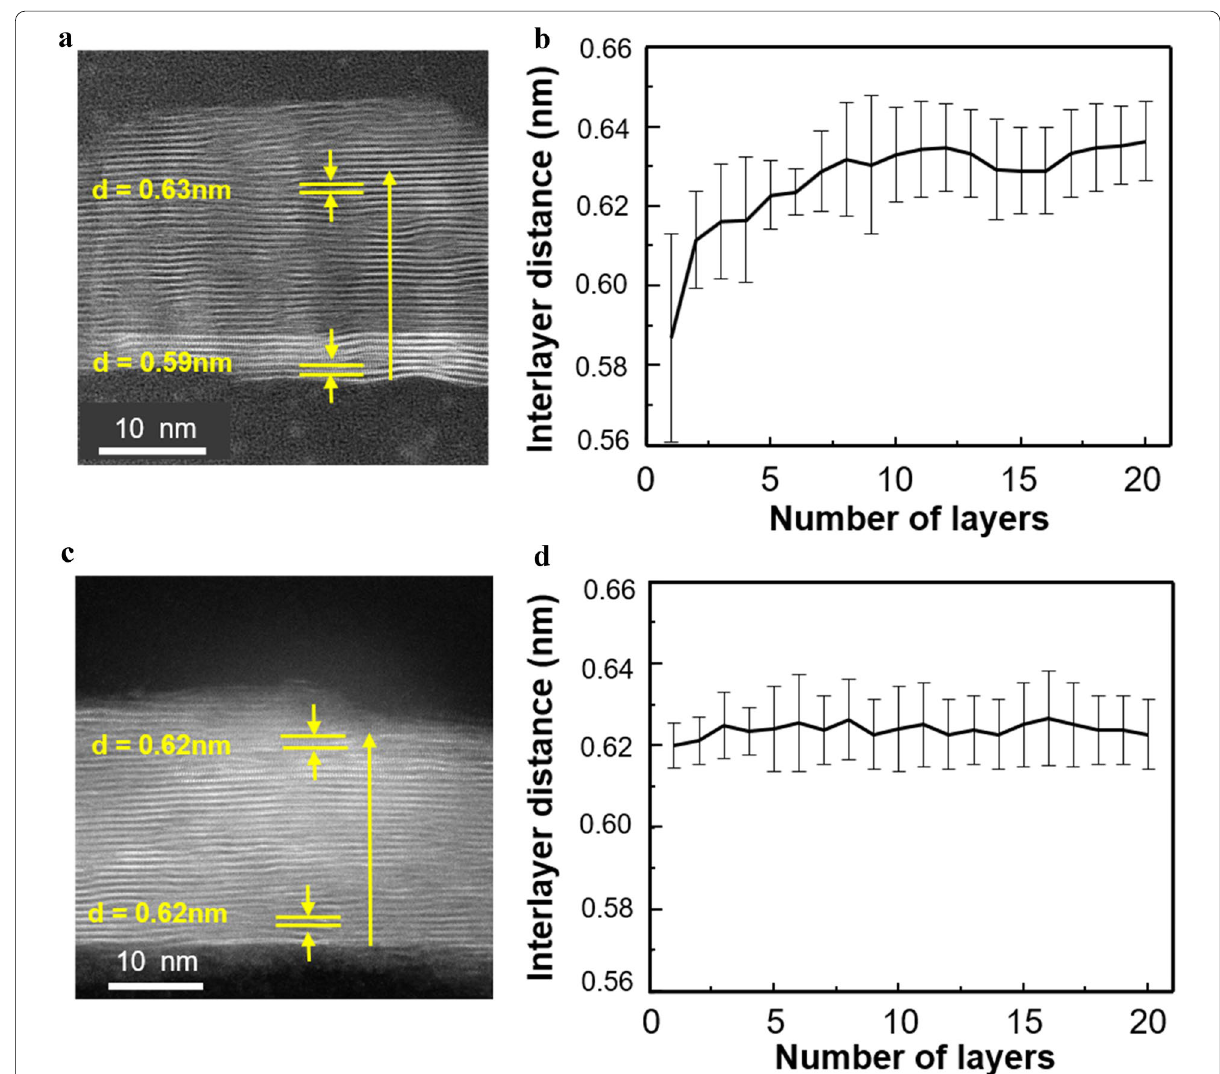
Fig. 2 Changes in the interlayer distance at the MoS 2 /SiO 2 interface. a Position at which the interlayer distance values were measured in the AS-MoS 2 films. b Plot of the interlayer distance of AS-MoS 2 . The black solid line represents the average value of the interlayer distance with error. c Position at which the interlayer distance values were measured in the TR-MoS 2 films. d Plot of the interlayer distance of TR-MoS 2 . The black solid line represents the average value of the distance with